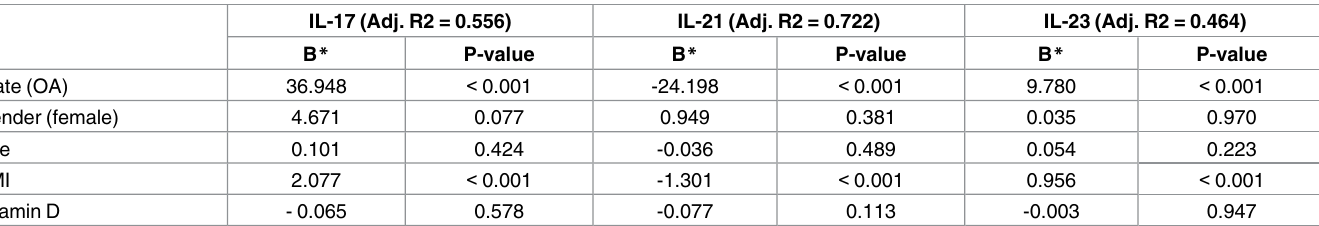
Table 2. Analysis of variables using logistic regression